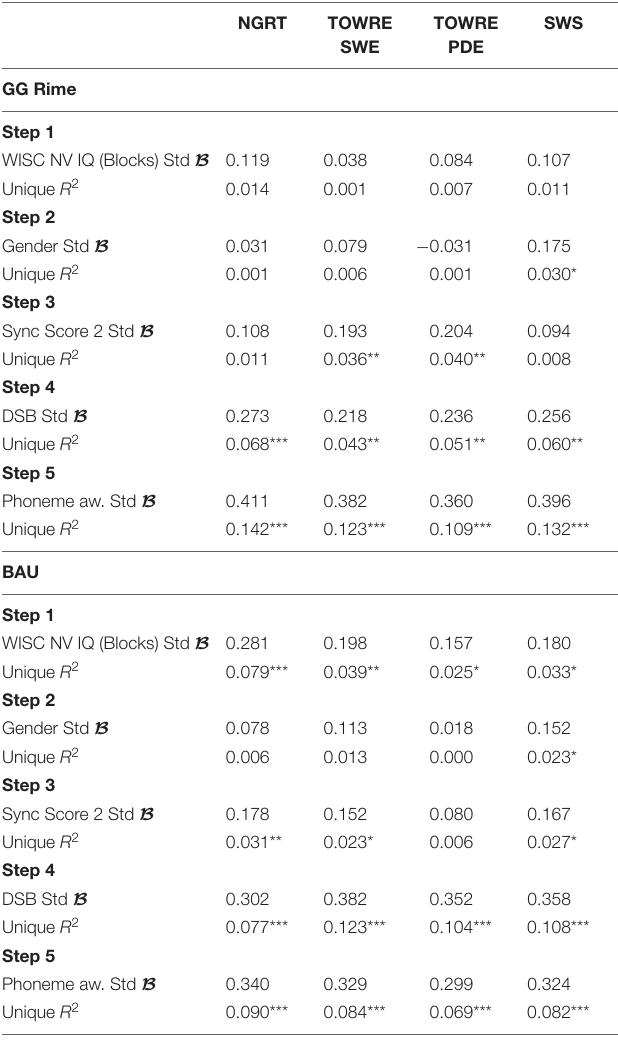
TABLE 6 | Unique variance ( R 2 change) in progression in the different literacy outcome measures taken at the end of the school year for GG Rime and BAU groups explained by the neurocognitive predictors measured at the beginning of the school